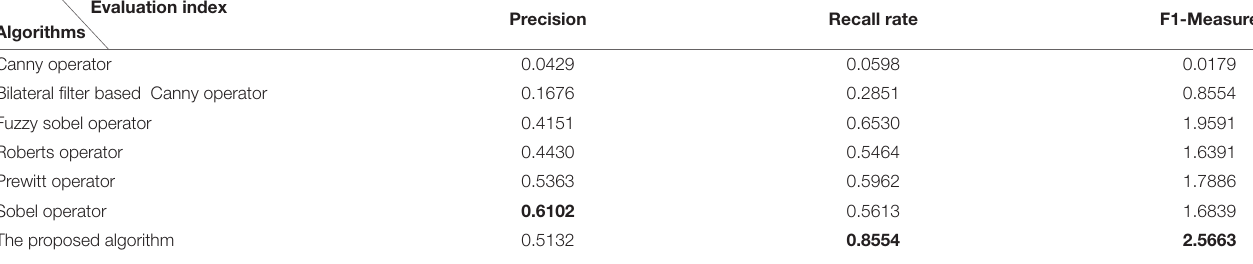
TABLE 4 | The evaluation indexes of the image segmentation with different algorithms comparison. Evaluation index Algorithms